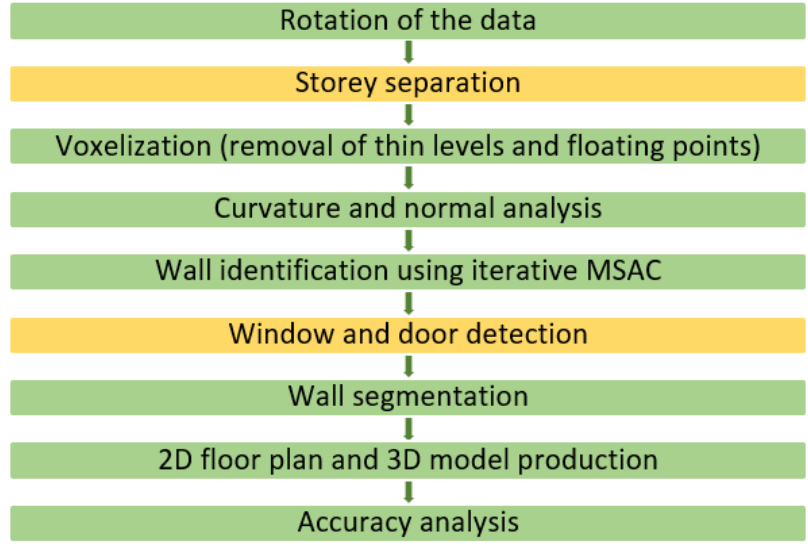
Figure 1. Flowchart of methodology, novel methodologies in yellow.